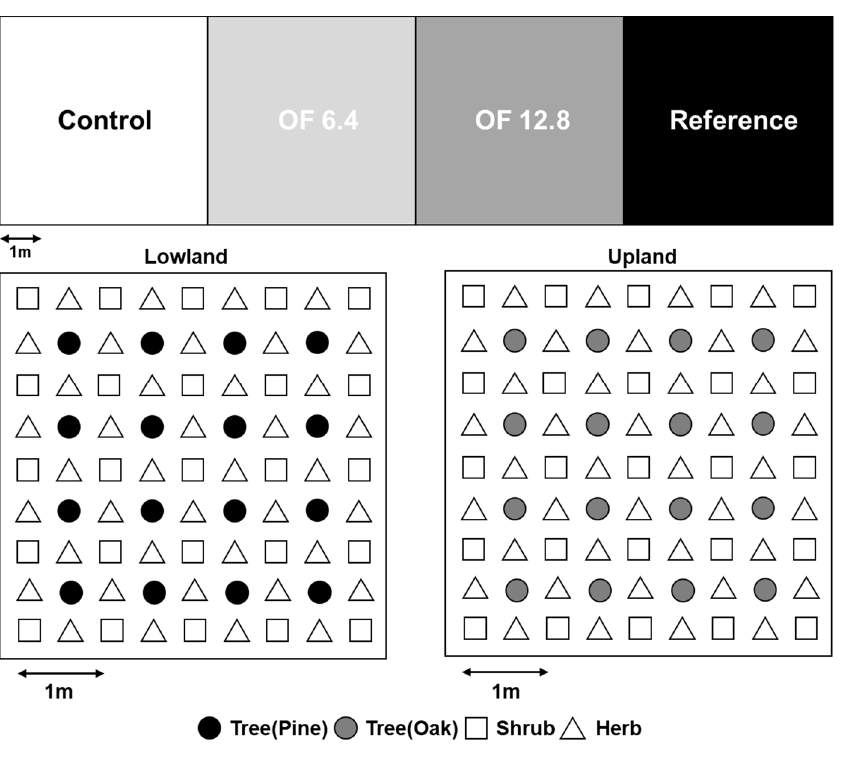
Figure 2. A conceptual diagram of a restoration design that carried out soil improvement and vegetation introduction. The soil amelioration plots were composed of control plots with fresh coal mine debris, OF 6.4 plot ameliorated with the treatment of organic fertilizer of 6.4 ton/ha, and OF 12.8 plot ameliorated with the treatment of organic fertilizer of 12.8 ton/ha. In addition, natural forest soil was selected as the reference plot for comparison. The model for vegetation restoration in the lowland was prepared by imitating the Pinus densiflora forest as a reference site, and the upland was prepared by imitating the Quercus mongolica forest as a reference site. This diagram depicts one full replicate of the experimental design, with five replicates for the lowland site and three replicates for the upland site.